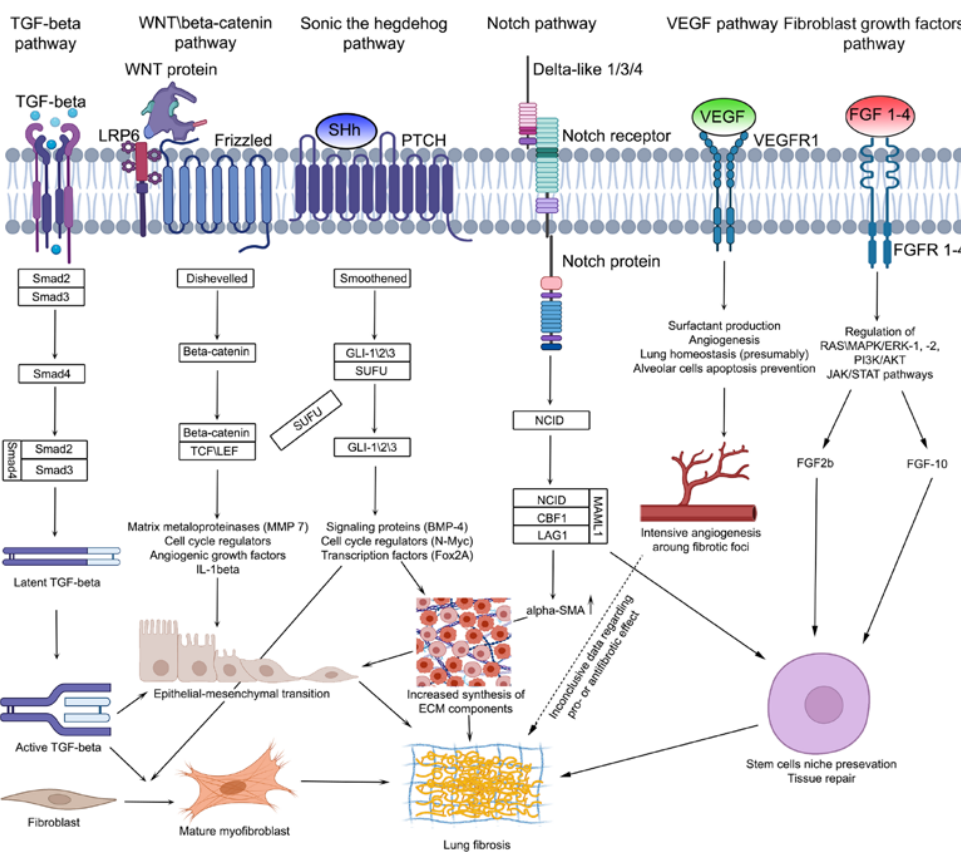
Figure 3. Overview of particular signaling pathways regulating pulmonary fibrosis development.